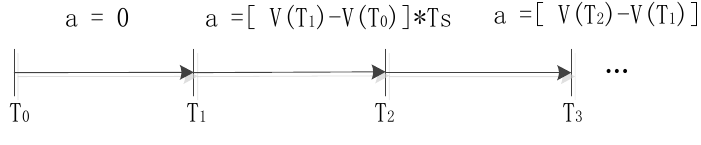
Figure 9. Alignment error curves at different output frequency of velocity. ( a ) The error curves of pitch angle; ( b ) the error curves of roll angle; ( c ) the error curves of heading angle.